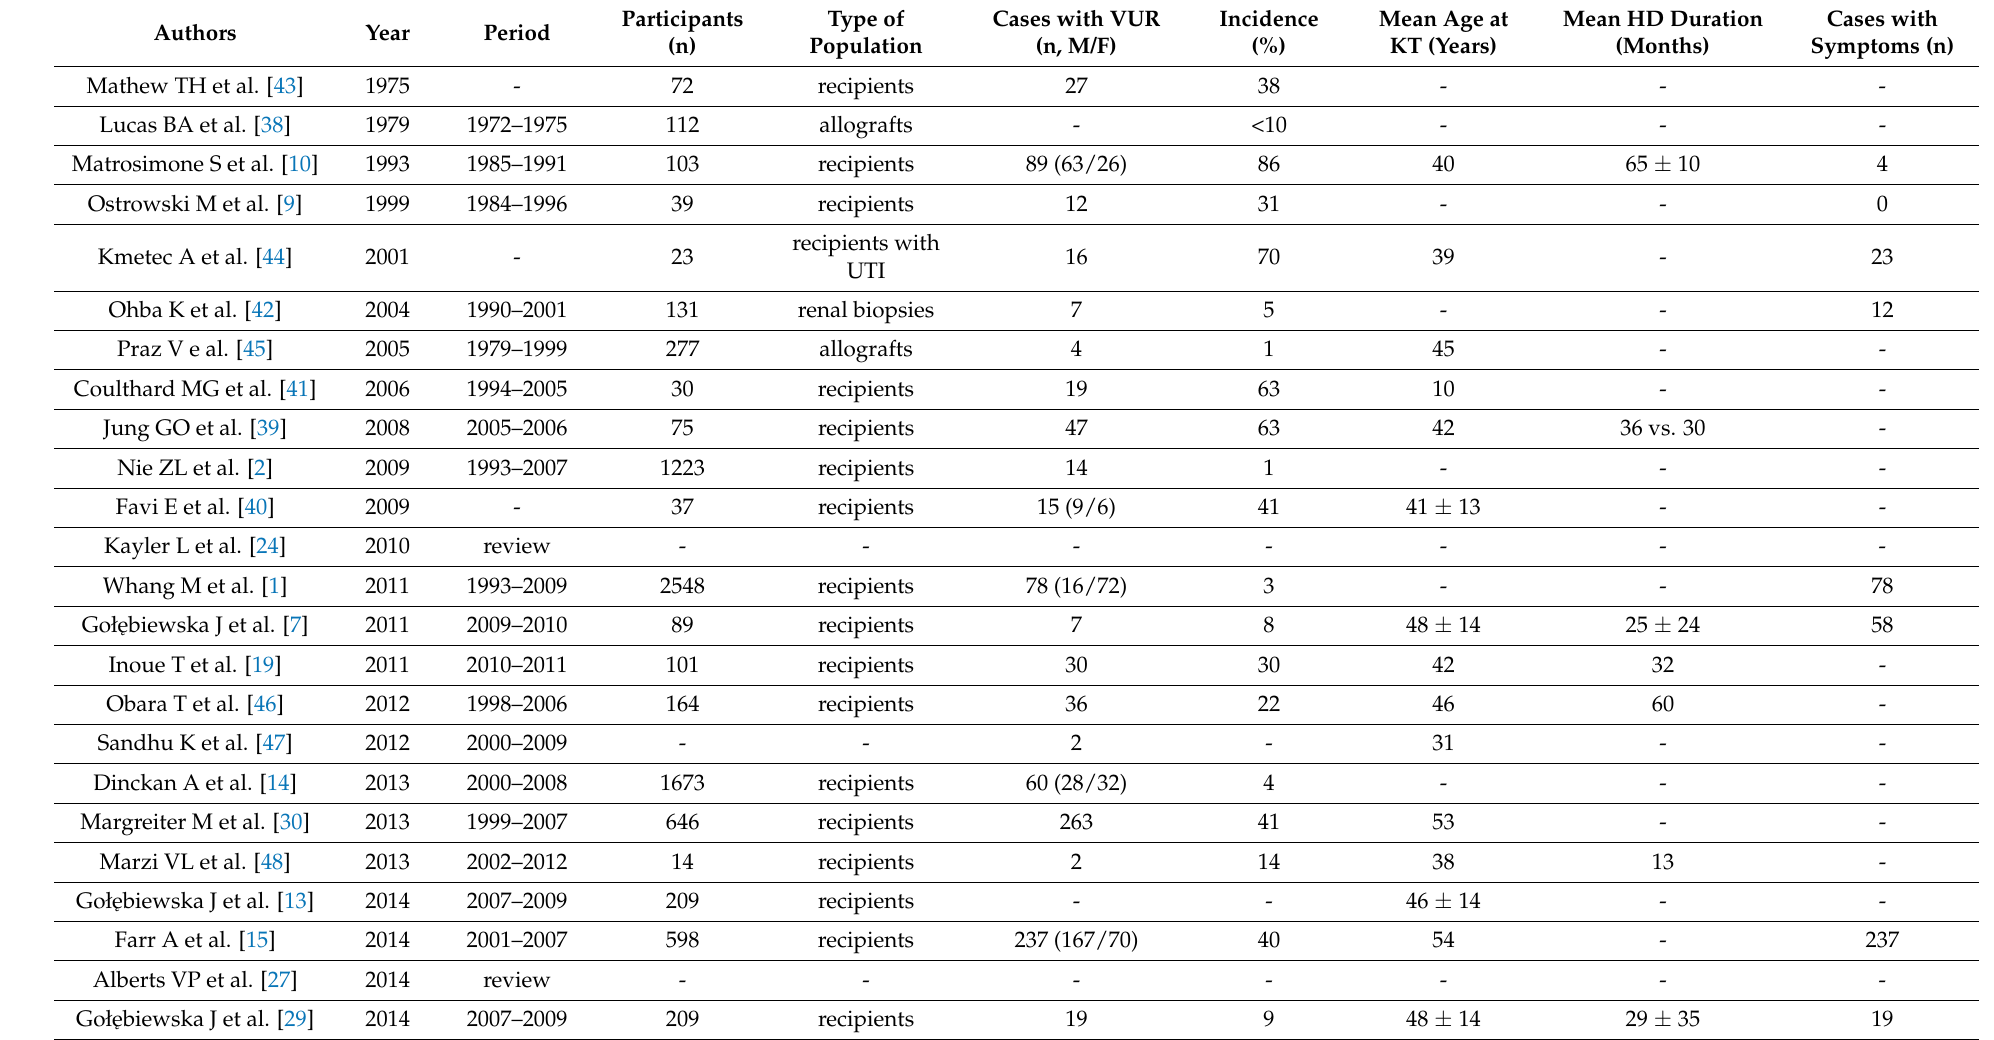
Table 3. Epidemiology of kidney transplant recipients with vesicoureteral